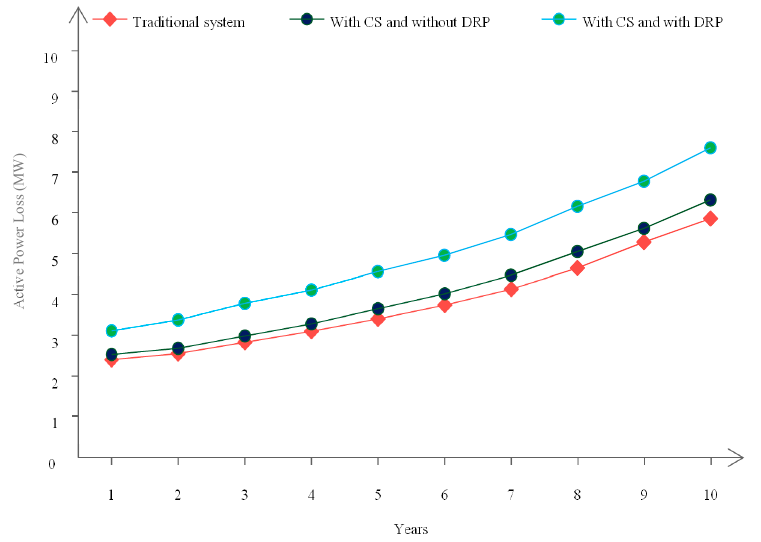
Figure 10. Rate of active losses of the studied network in different scenarios. Figures 11 and 12 show the effect of the proposed method in reducing network losses with annual load growth for different years. It can be seen that the combined use of load management programs and parking locations together has significantly diminished both the maximum losses and the total energy wasted in the network.